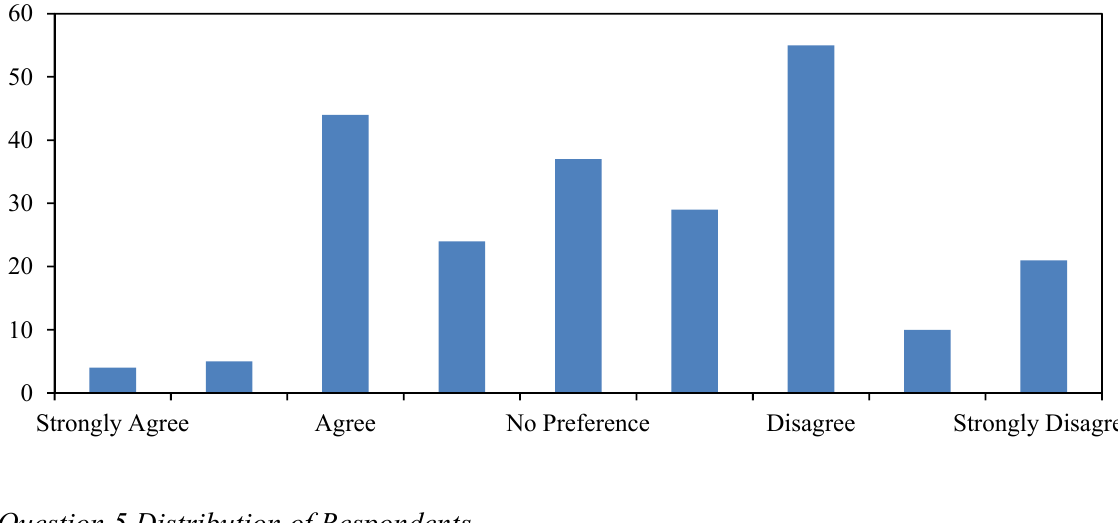
Figure 4. Graph of responses to the statement “I would trust computer analysis (without human involvement) of planetary science data”.